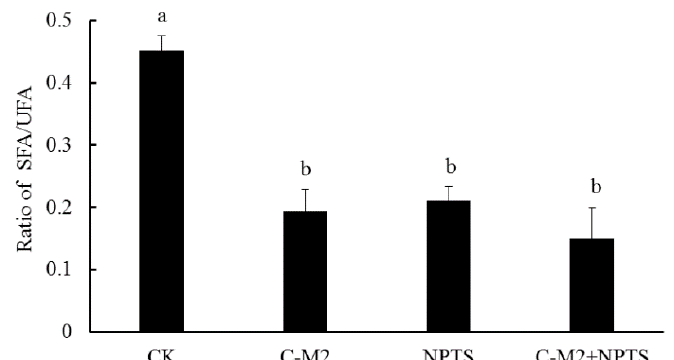
Figure 6. Ratios of SFA/UFA in the cell membrane of Morganella sp. wf-1 with different treatments. Different lowercase letters (a, b) indicate significant differences ( p < 0.05).